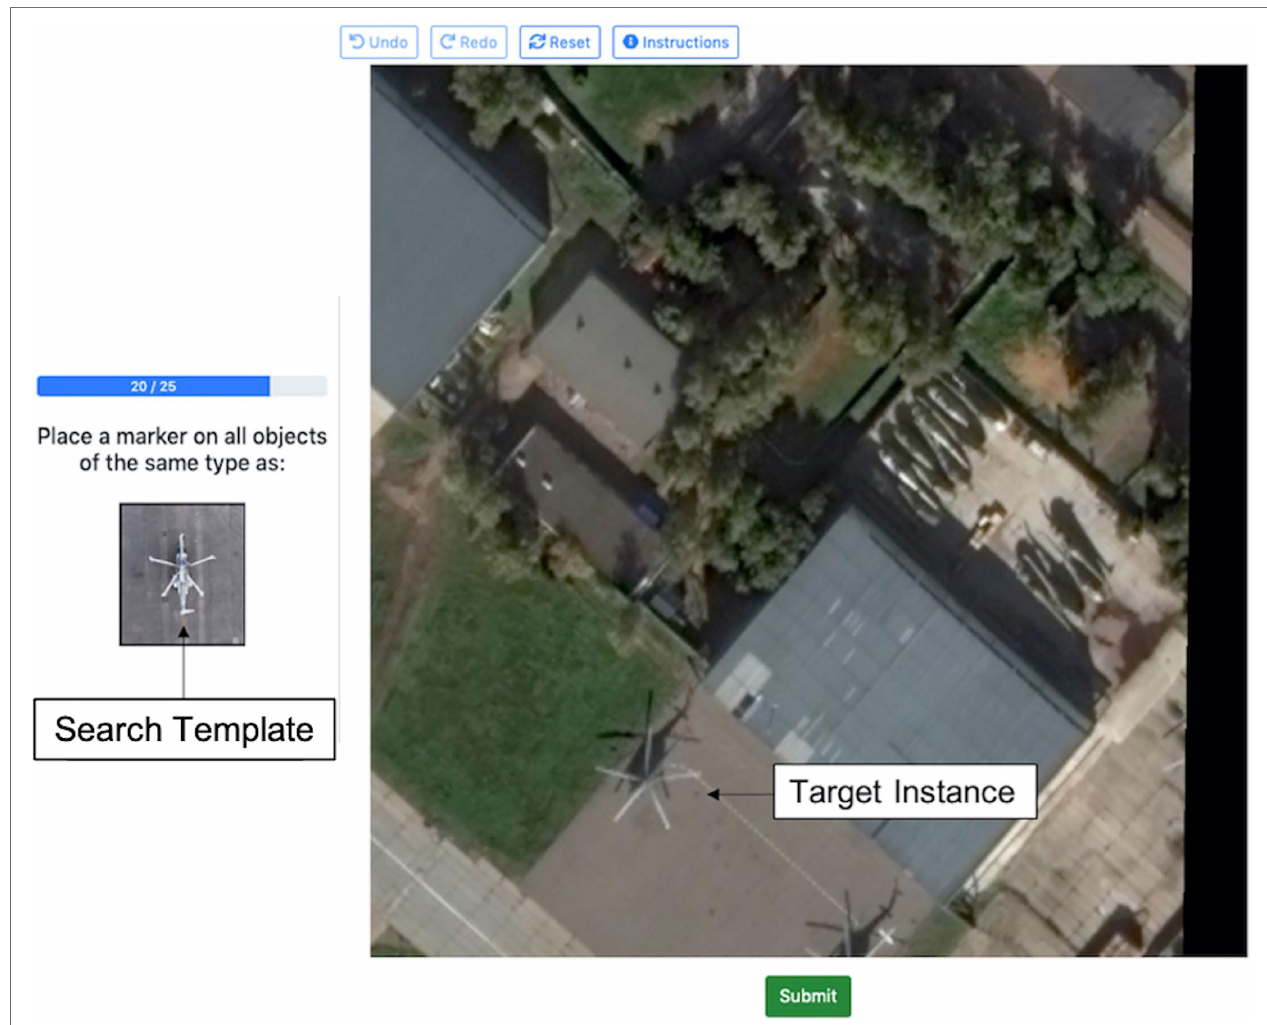
FIGURE 1 | Annotated example of an experimental trial in Experiment 1. The helicopter shown in the thumbnail target image is the “search template” and the helicopter shown in the larger search image is a “target instance.” Image provided by iSAID dataset (Zamir et al., 2019) using Google Earth